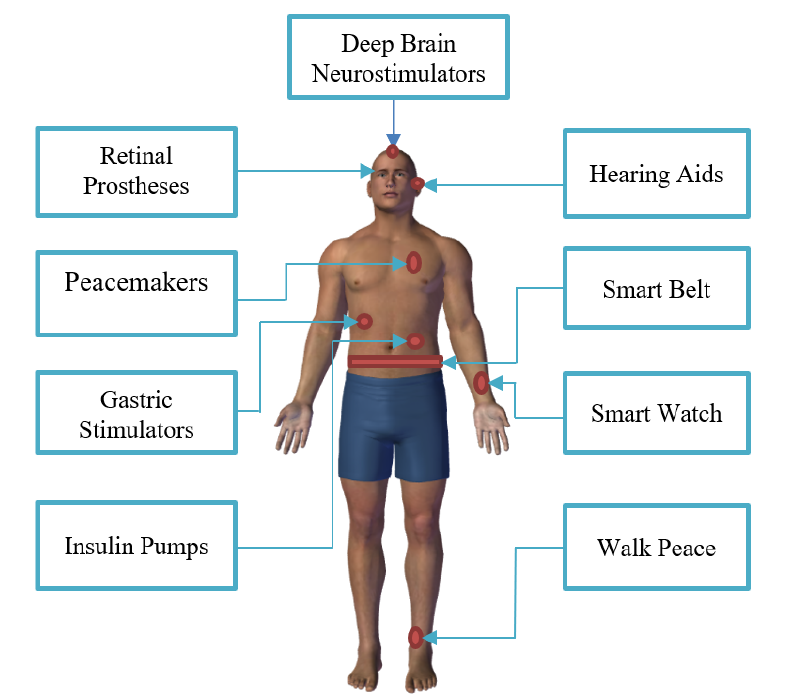
Figure 1. Implantable and wearable medical devices for various body